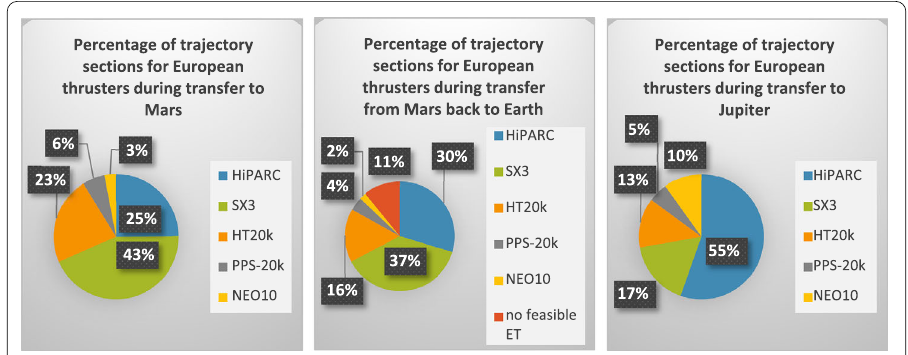
Figure 7 Percentages of trajectory sections for the cluster of European thrusters